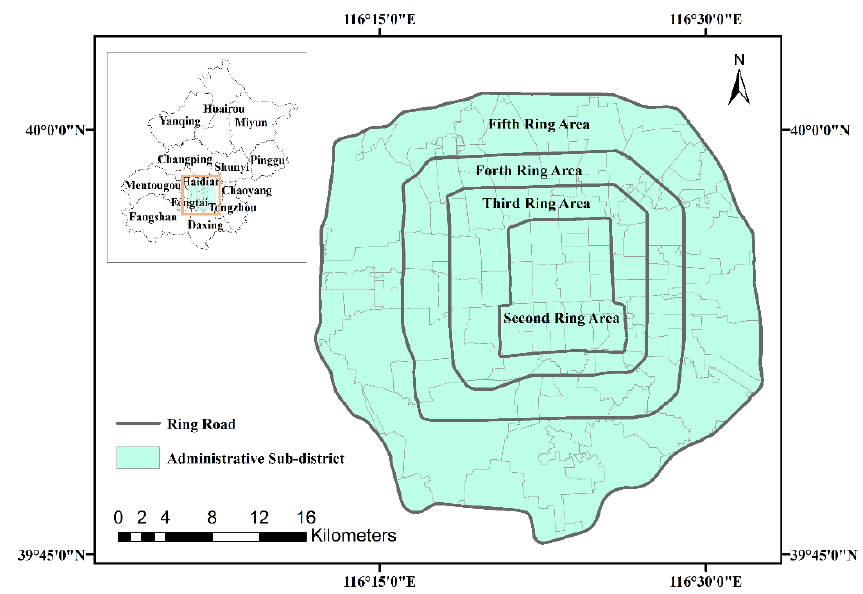
Figure 2. Study area: Fifth Ring Road area of Beijing.